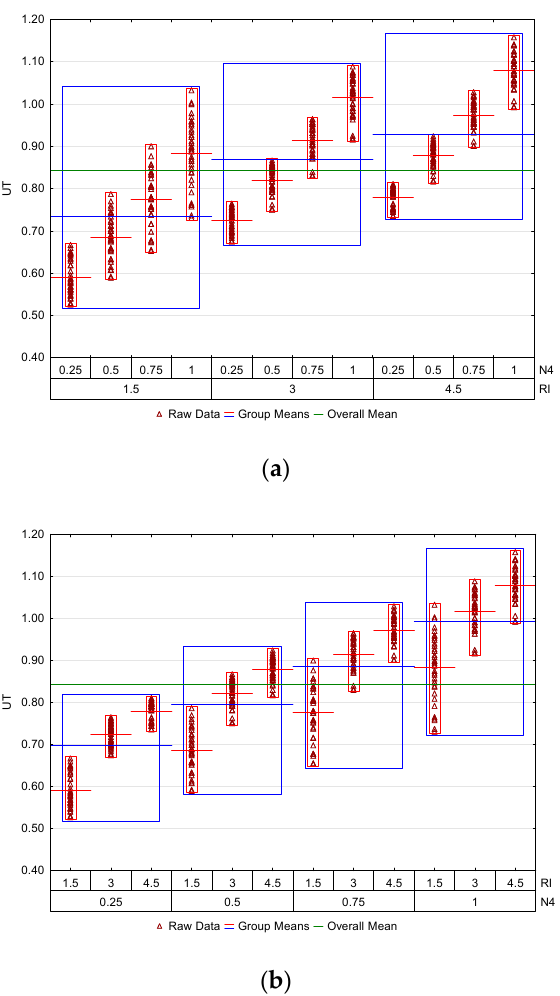
Figure 8. Variability plots of UT illustrating: ( a ) N4 impact for various RI; ( b ) RI impact for various